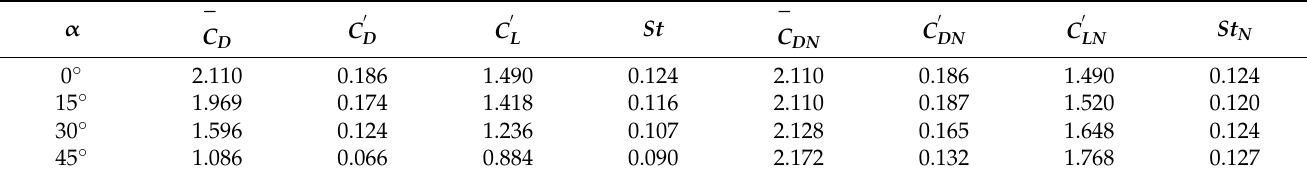
Table 3. Force coefficients and Strouhal numbers for different yaw